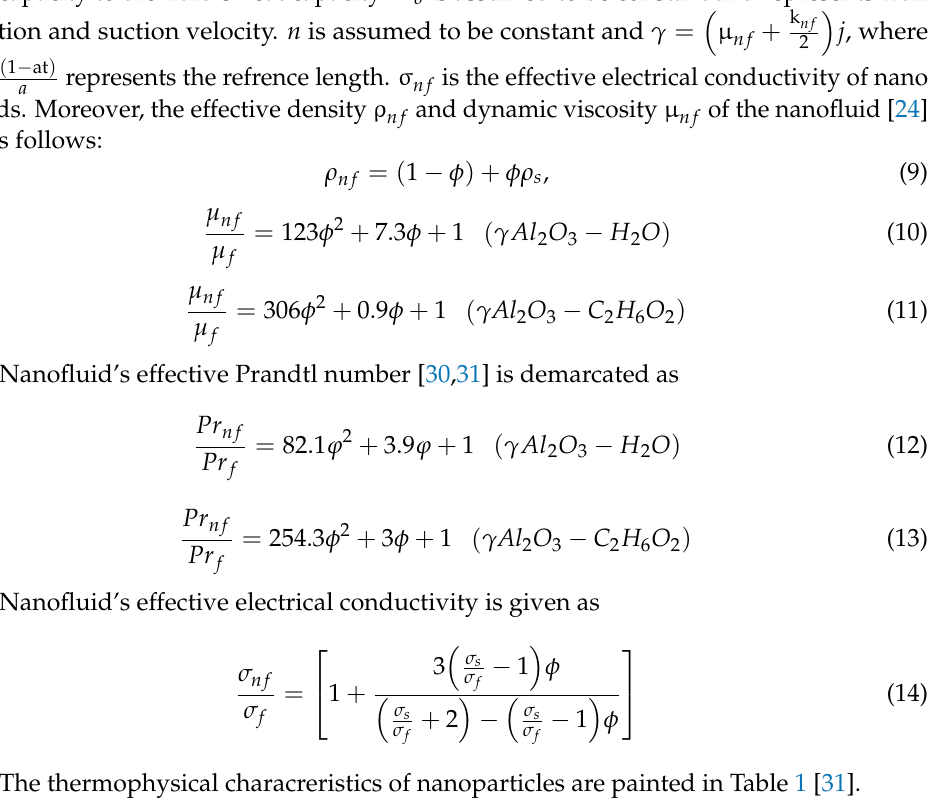
Figure 1. Geometry of the problem .